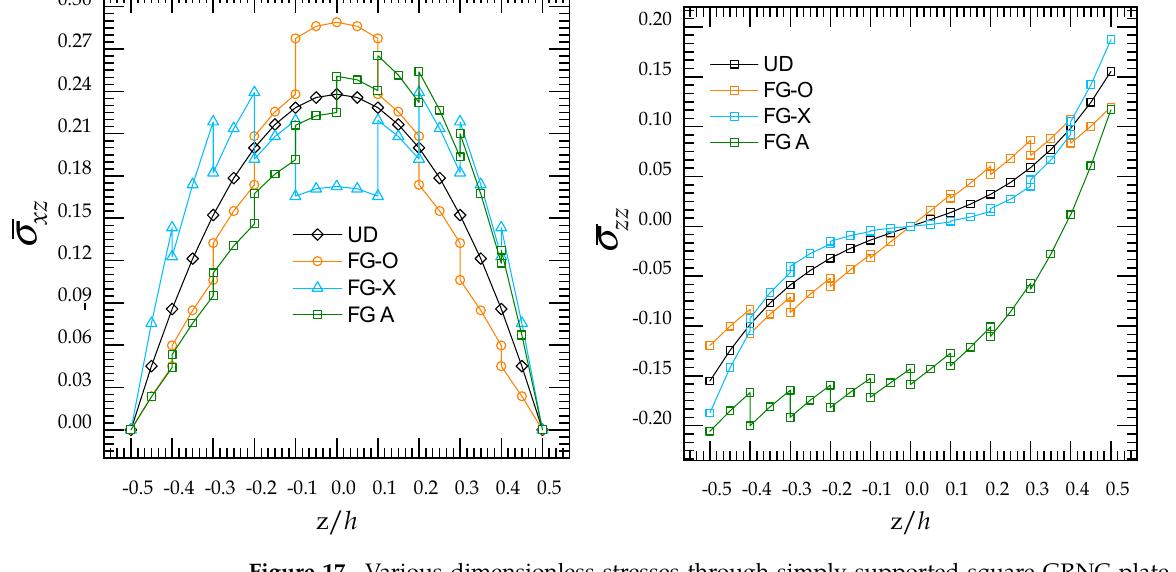
= 1%, a / h = 5, a = b = 10 2 nm, GPL GPL GPL